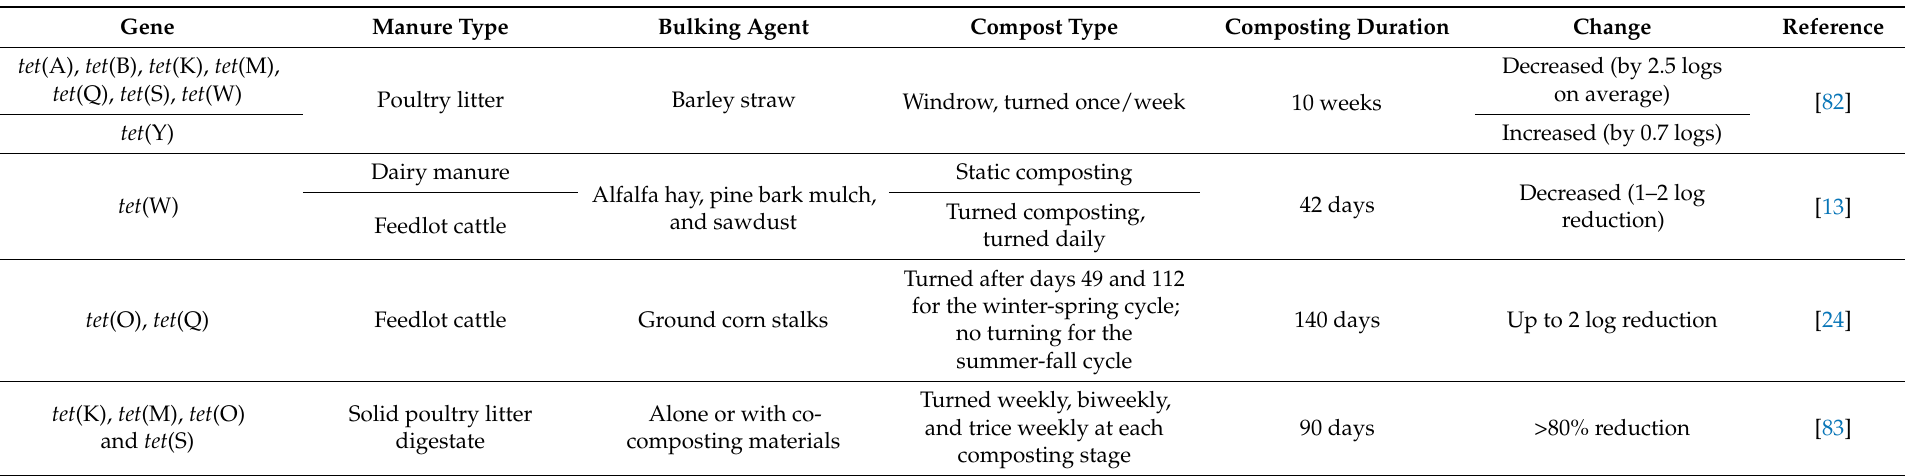
Table 4. Effect of composting of animal manure on tetracycline resistance